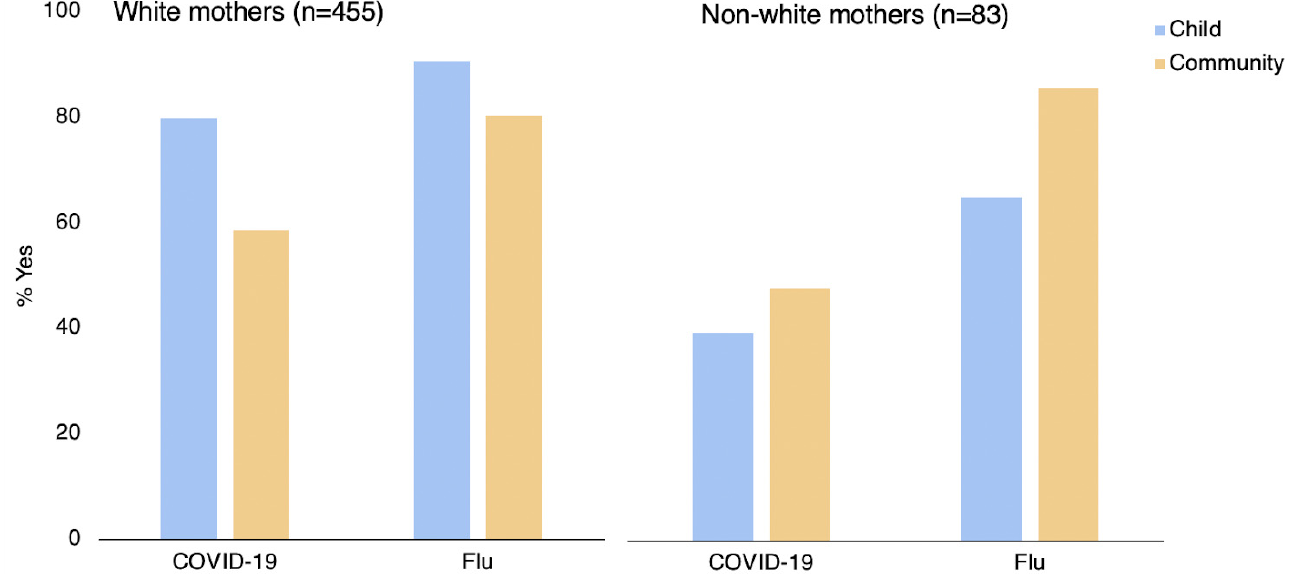
Figure 4. The effect of type of risk frame (child vs. community) by type of disease (Flu vs. COVID-19) on vaccination intention separated by white ( left ) and non-white ( right ) mothers.